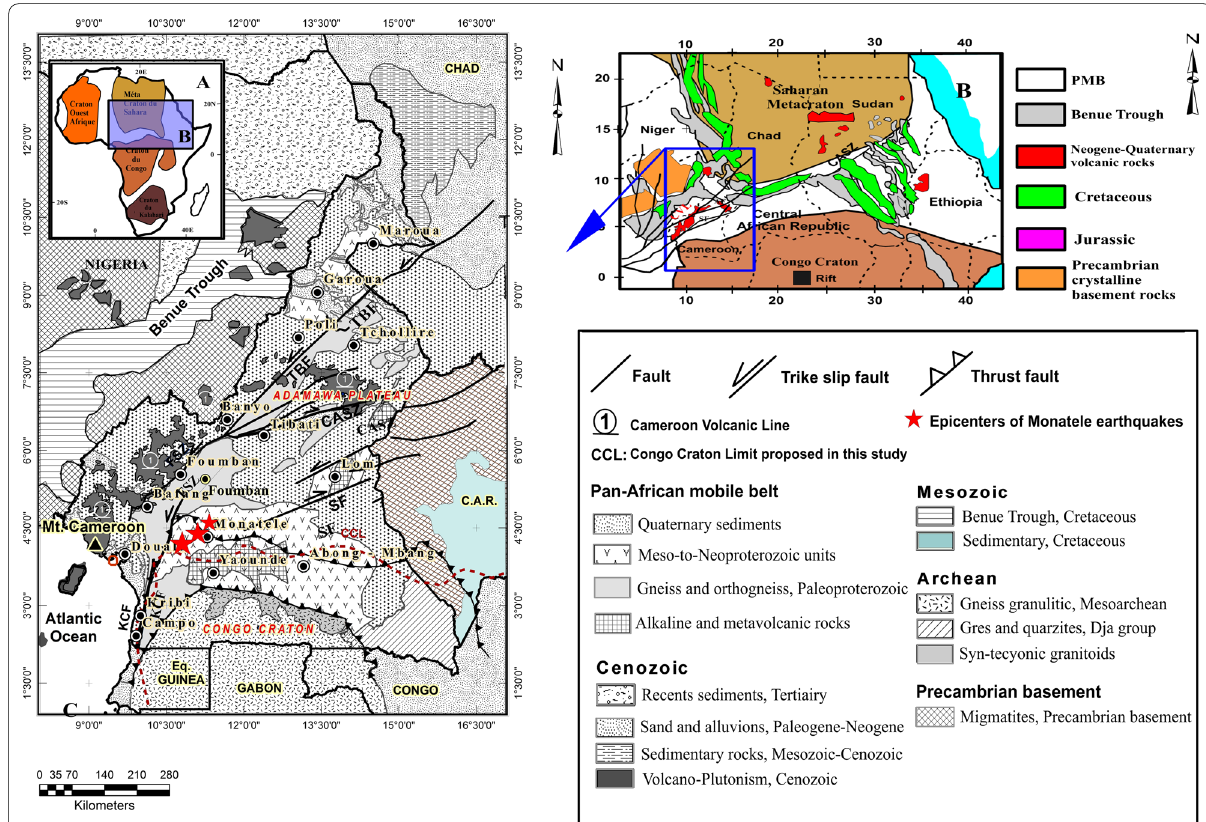
Fig. 1 A African Precambrian Cratons, metacratons and Orogenic belts (modified after Meert and Lieberman 2007). B Tectonic map of the Central Africa Orogenic Belt (CAOB) and the surrounding tectonic elements [modified from the Tectonic map of Africa by Commission for the Geological Map of the World (CGMW)]. C Geological map of Cameroon and surrounding countries modified from (Toteu et al.